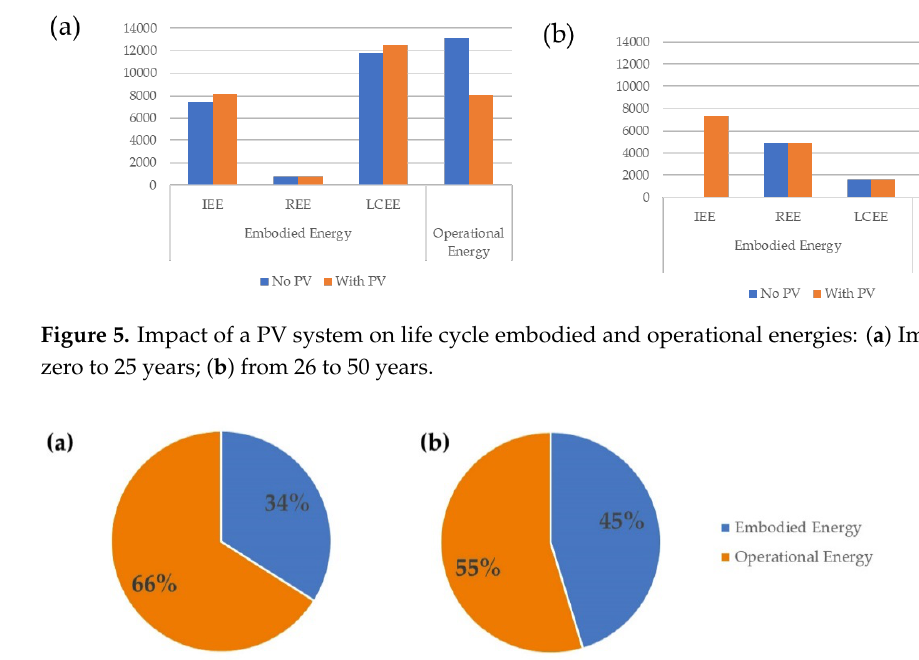
Figure 6. Impact of a PV system on life cycle energy: ( a ) Without PV; ( b ) With PV.